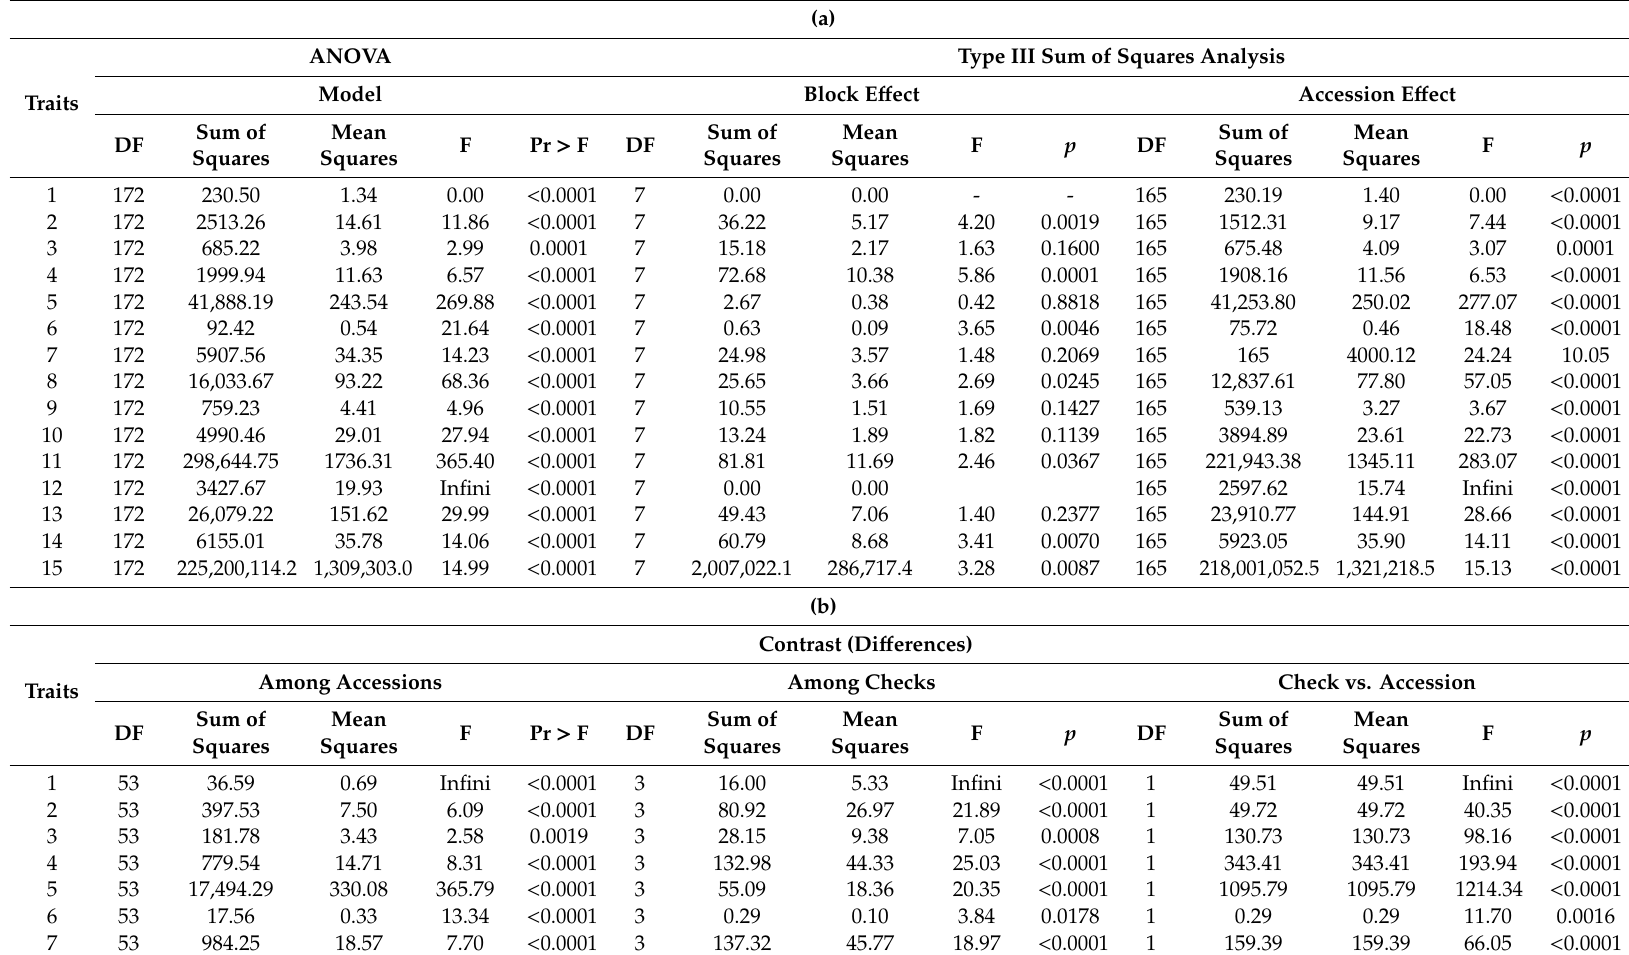
Table 2. ( a ) Analysis of variance (ANOVA) and type III sum of squares analysis for the selected quantitative traits* at the Tanzania Agricultural Research Institute (TARI, Arusha region) during the 2018 cropping season; ( b ) analysis of the di ff erences and interactions between accessions and checks for the selected traits (all species) at the Tanzania Agricultural Research Institute (TARI, Arusha region) during the 2018 cropping